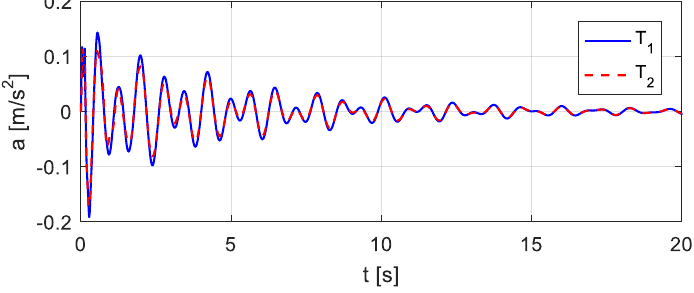
Figure 21. Estimated accelerations in case wheel T 1 bumps.